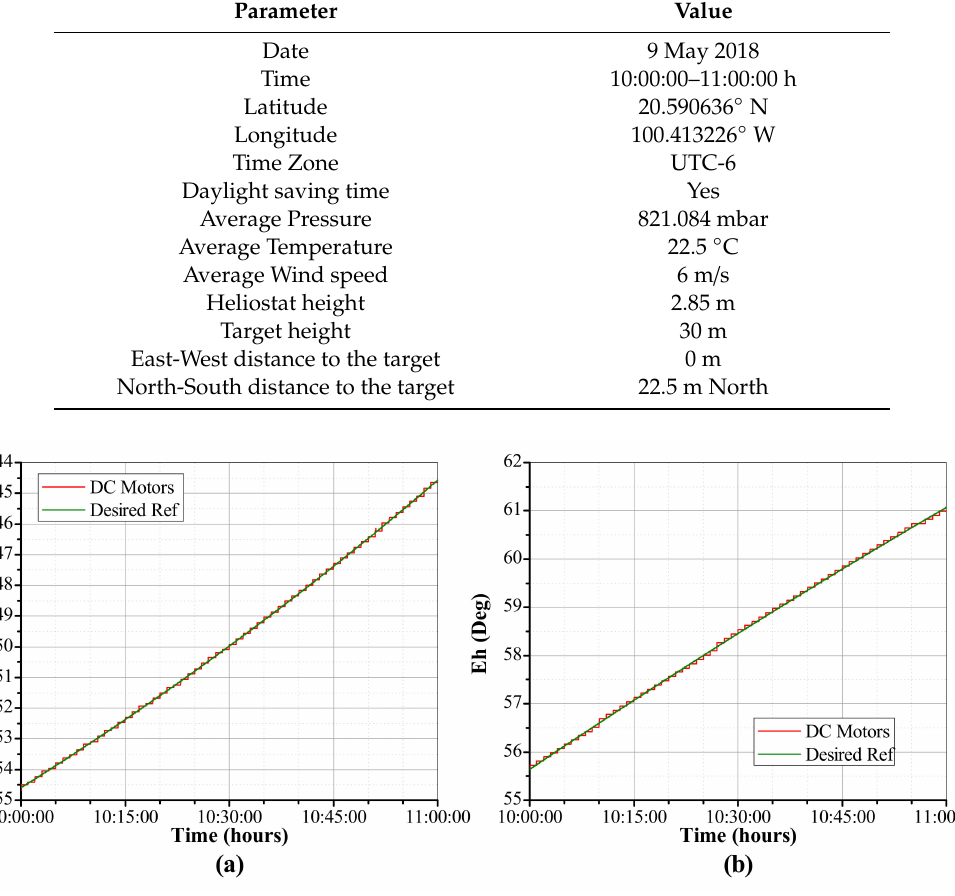
Figure 22. Orientation control response of the DC motors at no load for the azimuth angle ( a ) and the elevation angle ( b